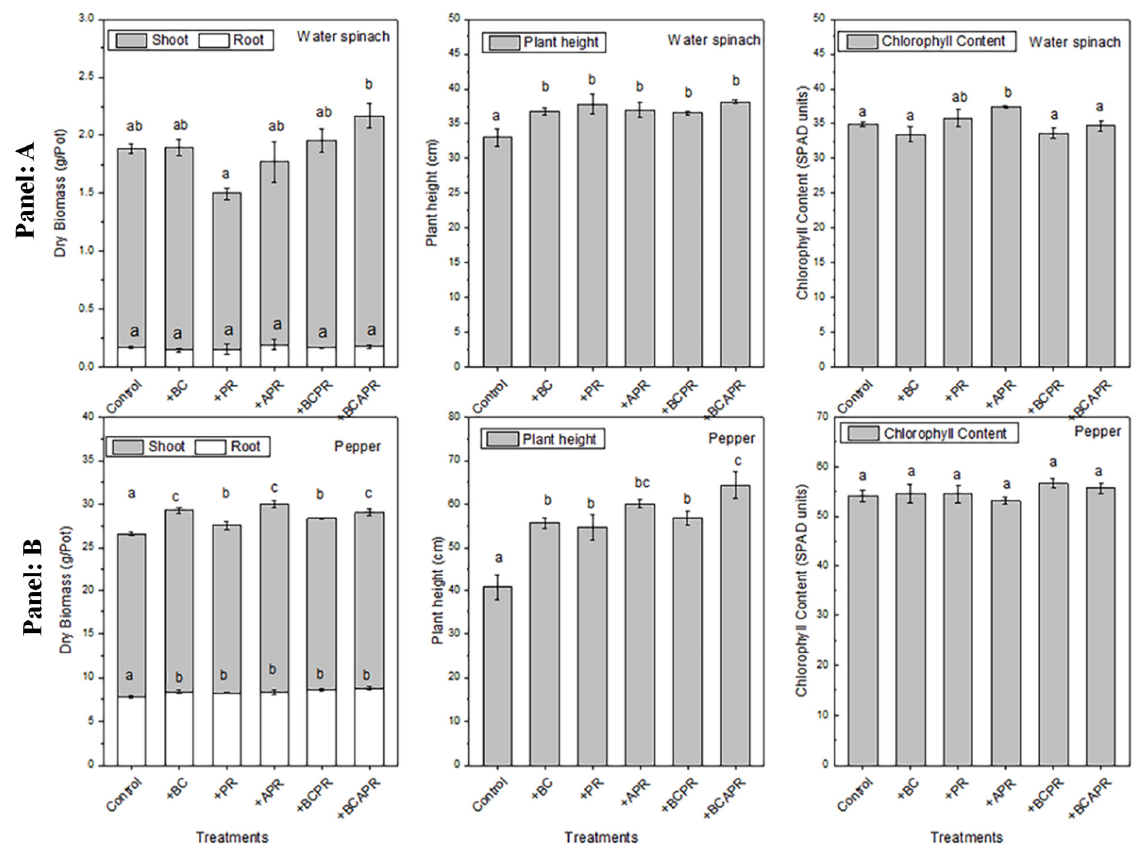
Figure 3. Plant heights, leaf chlorophyll contents and biomass of water spinach and pepper plants in successive cultivations with different amendments. The number of replicates was three. Different lowercase letters indicate significant differences at p < 0.05. Panel A: first cultivation, Panel B: second